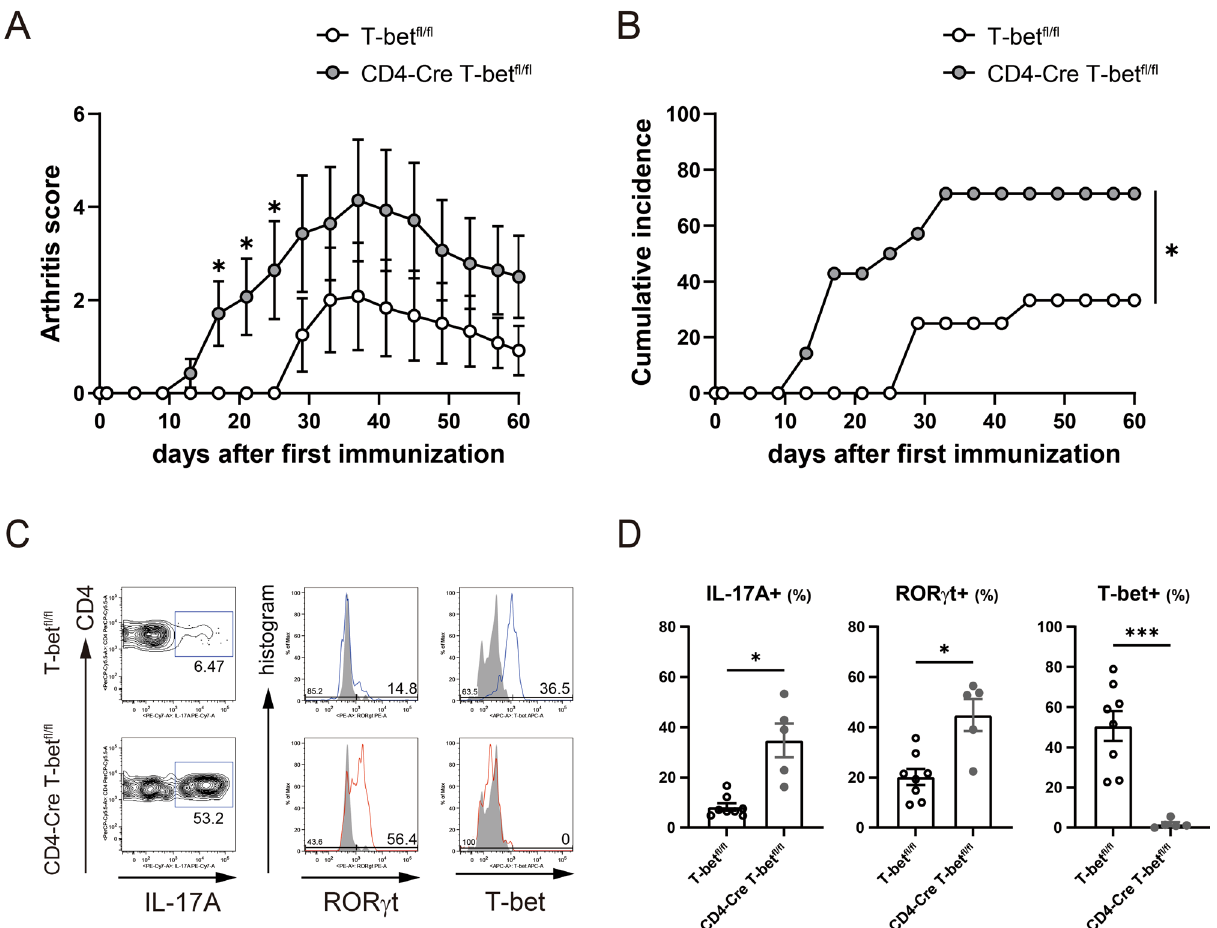
Figure 5. CIA in CD4-Cre T-bet fl/fl mice was exacerbated and CD4 + T cells in the arthritic joints of cKO mice showed higher RORγt expression and increased IL-17A production. T-bet fl/fl mice (n = 12) and CD4-Cre T-bet fl/ fl (cKO) mice (n = 14) were immunized intradermally with chicken CII emulsified with CFA on days 0 and 21. ( A ) Severity of CIA. ( B ) Cumulative incidence of arthritis. Ankle joints with active arthritis at day 35 post first immunization were removed from T-bet fl/fl mice (n = 8) and cKO mice (n = 5) ( C , D ) The percentage of IL-17A, RORγt, or T-bet + cells. Data are presented as mean ± SEM. Statistical tests: Welch’s t test ( A , C ), and Log-rank test ( B ). (* P < 0.05, *** P < RNA sequencing analysis revealed T‑bet in CD4 + T cells selectively inhibited expression of Th17 cell‑related genes, but not other subsets of CD4 + T cells. To clarify the change in transcrip- tome of CD4 + T cells caused by T-bet deficiency, we performed RNA sequencing and profiled the transcrip- tome in CD4 + T cells of T-bet fl/fl and cKO mice. We observed different gene expression between the two strains (Fig. 6A). T-bet deficiency in CD4 + T cells altered the expression of 52 genes with fold change more than 2.0 and false discovery rate (FDR) adjusted P -value of less than 0.05. Up-regulated 29 genes included several Th17 cell-related genes, while 23 down-regulated genes included several Th1 cell-related genes in cKO mice (Fig. 6B). Gene Ontology (GO) analysis of the differentially expressed genes showed a significant enrichment for inflam- matory response, lymphocyte migration, and IL-17 production (Fig. 6C). Since T-bet deficiency might alter expression of other Th cell subsets, we generated a heatmap that included many of the Th cell signature genes 11 . The heatmap indicated decreased expression of Th1 cell-related genes and increased expression of Th17 cell- related genes. Intriguingly, the expression levels of Th2 cell-related genes were comparable between the two strains (Fig. 6D and Fig. S5). Taken together, these results show that T-bet in CD4 + T cells selectively inhibits Th17 cell-related genes, but not other subsets of CD4 + T cells. We searched our RNA-seq dataset of CD4 + T cells for the genes responsible for the enhanced commitment to the Th17 lineage by T-bet deficiency. Although tran- scriptional regulation of Th17 cells and the related transcription factors were extensively studied and reviewed in the literature 12–14 , we found no difference in the expression levels of the candidate genes (Fig. S6).